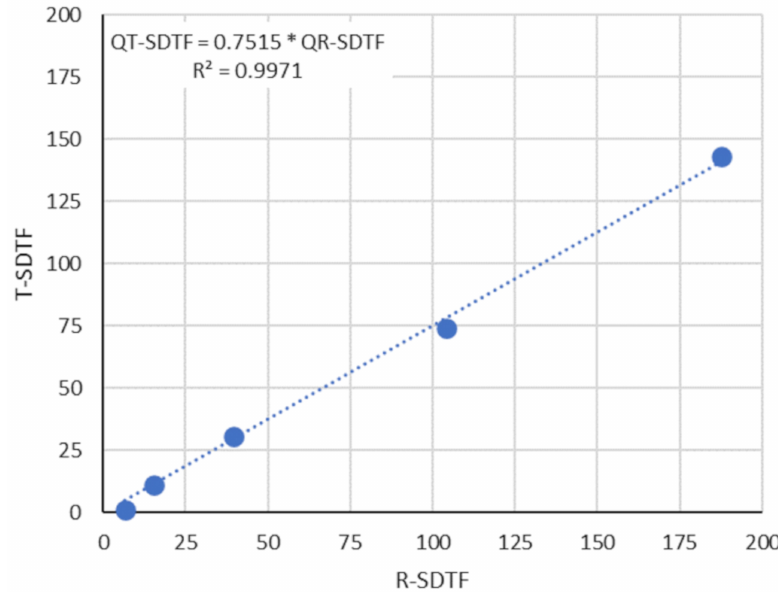
Figure 10. T-SDTF vs. R-SDTF water yield